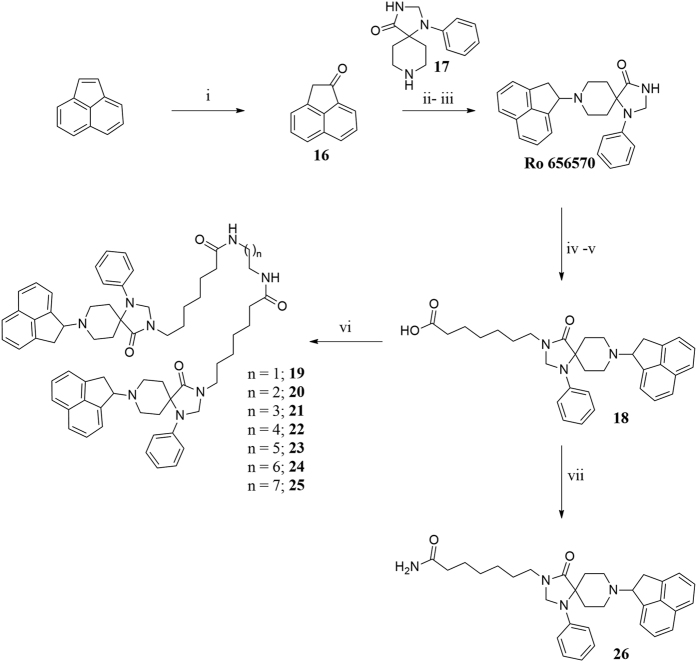
Synthesis of non-peptide homodimers 19–25: (i) m-chloroperbenzoic acid, CH2Cl2, rt, 24 h; (ii) Titanium (V)isopropoxide; (ii) NaBH3CN, EtOH, rt, 2 h; (iv) Ethyl 7-bromoheptanoate, NaH, DMF, 60 °C 2 h; (v) aq NaOH 15% w/v, Dioxane, rt, 5 h; (vi) diamine, HATU, DIPEA, DMF, rt, 5 h; (vii) NH3, HATU, DMF, −20 °C to rt, 12 h.